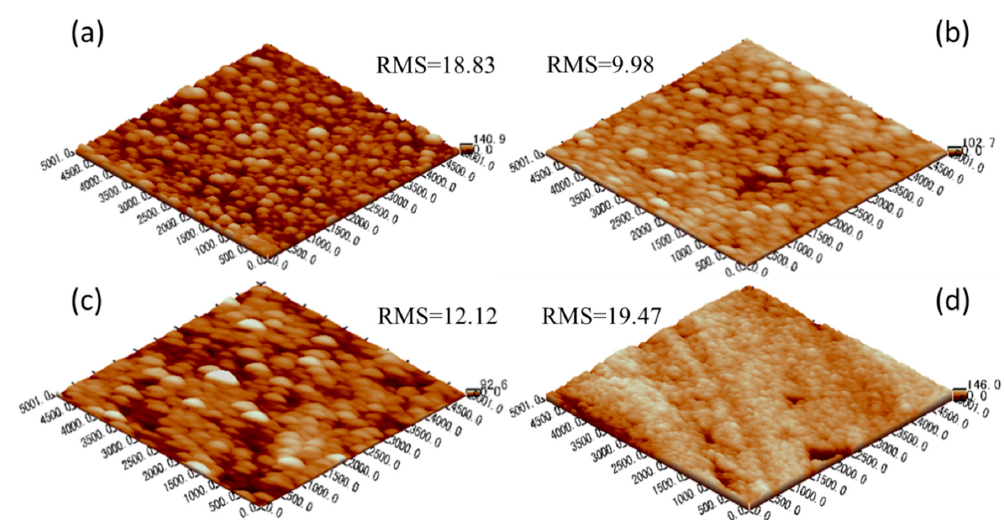
Figure 6. 3D AFM images of the coatings, ( a ) as-deposited after heat treatment at 200 °C for ( b ) 200 h, ( c ) 800 h and ( d ) 1200 h.